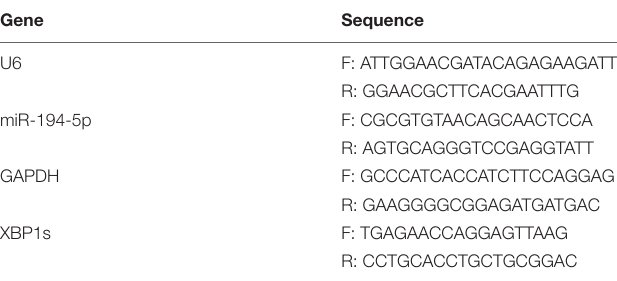
TABLE 2 | Real-time quantitative PCR (qRT-PCR) primers used in this